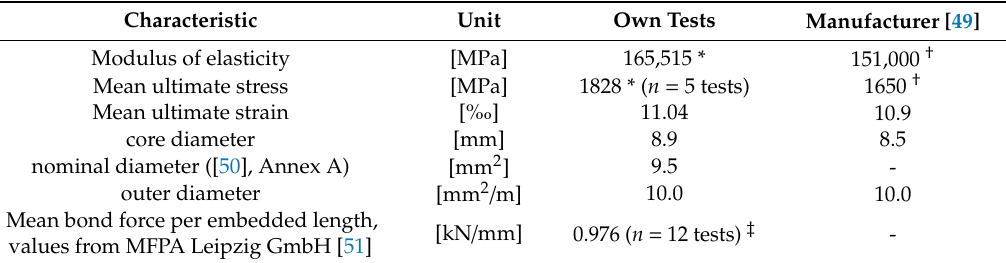
Table 2. Reinforcement characteristics for carbon bars.